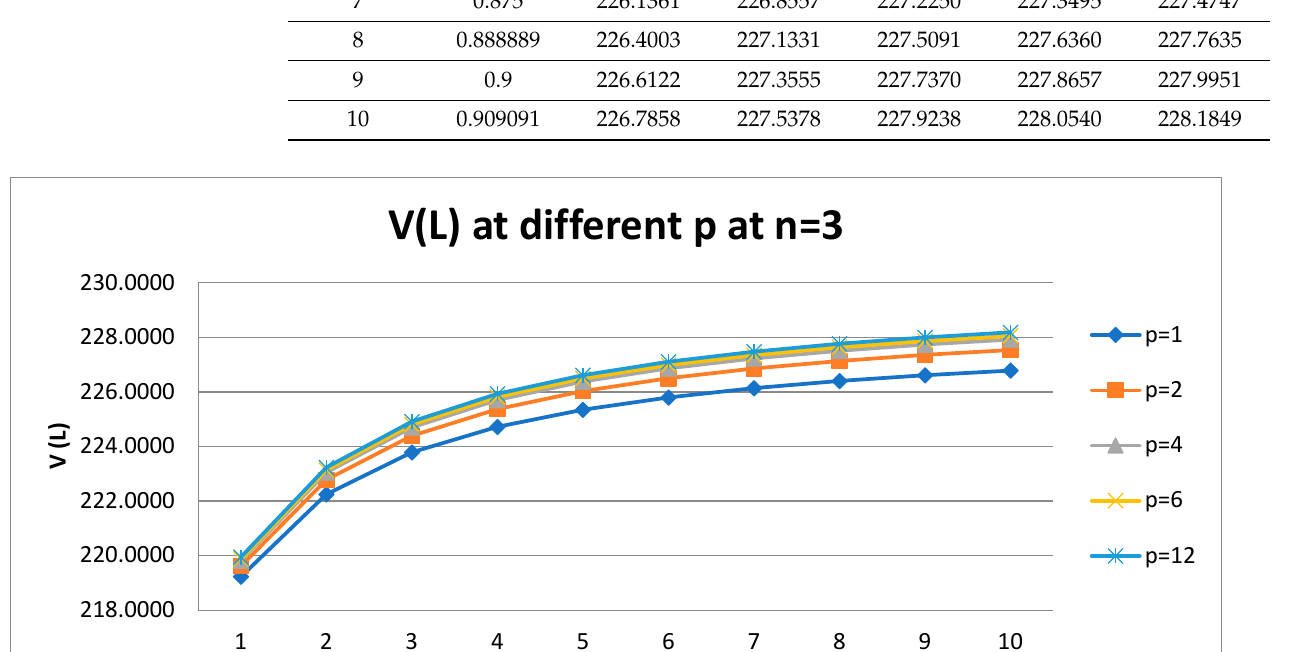
Figure 5. Dependence of the company value, V , on leverage level L at different frequency of payments of tax on profit p for three-year company.